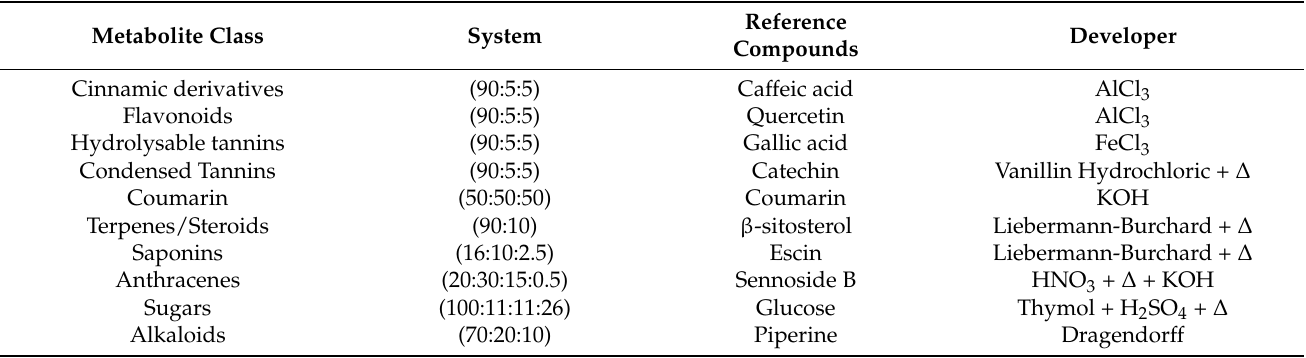
Table 4. Chromatographic conditions for identification of chemical profile by thin layer chromatogra- phy